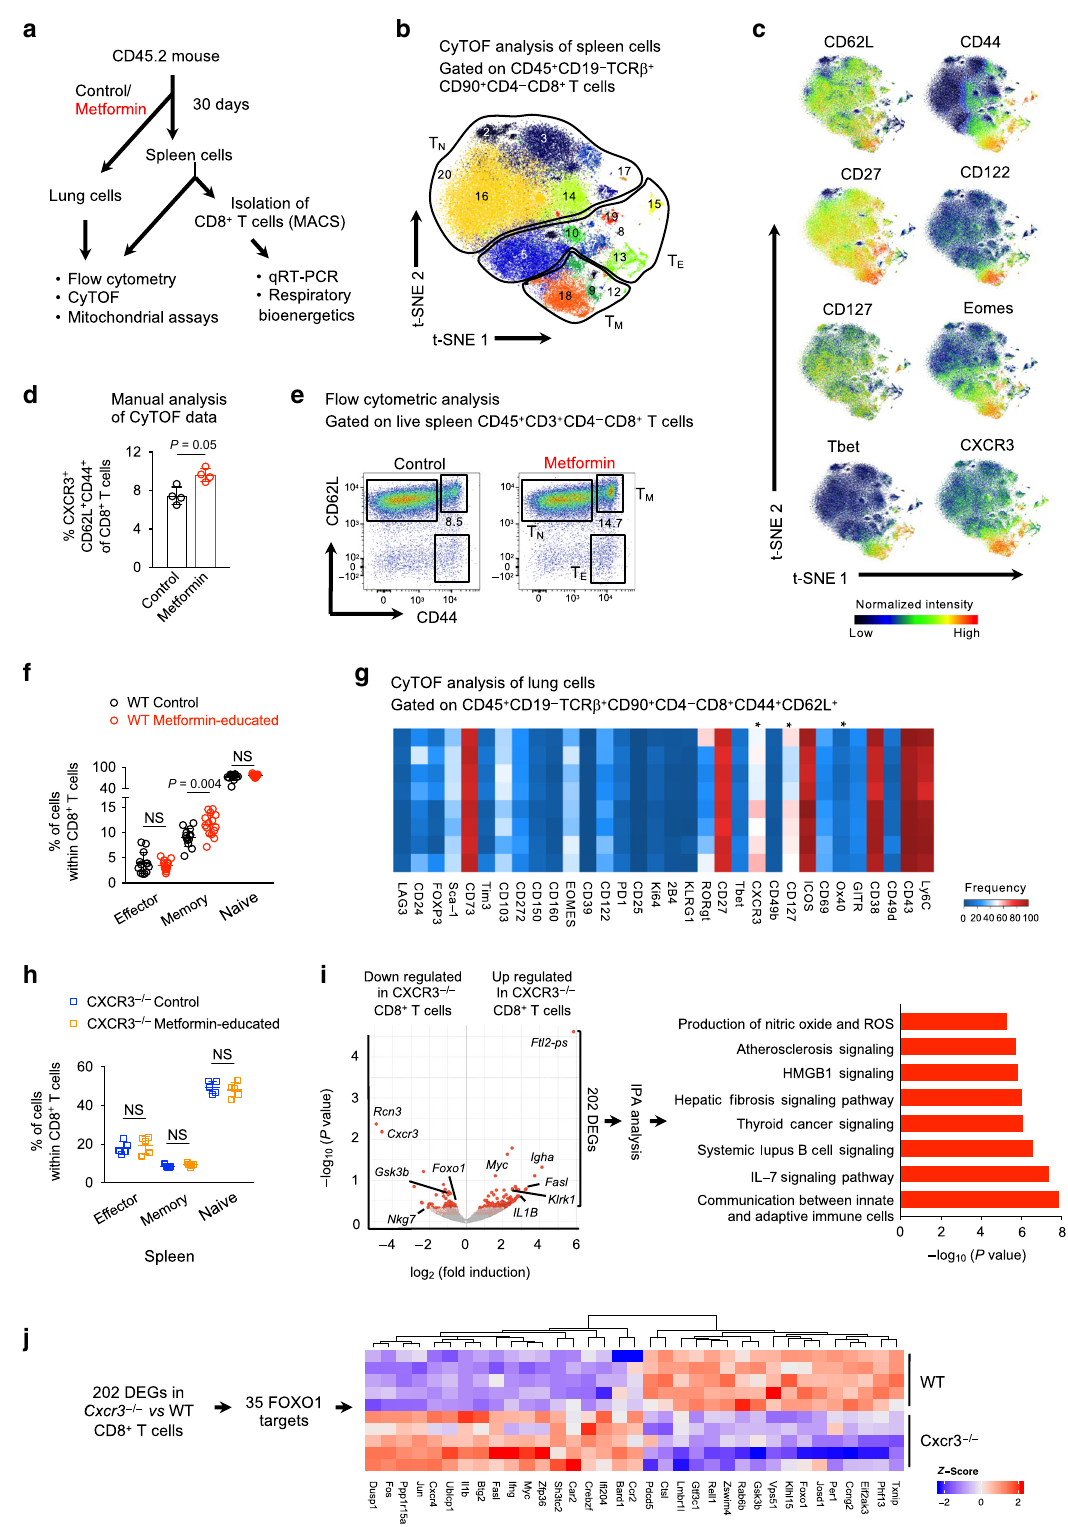
(Supplementary Fig. 4e) from metformin-treated naive mice. To test if CXCR3 was involved in the metformin-mediated expansion of CD8 + T M cells in the spleen and lung, we compared untreated and metformin-treated Cxcr3 − / − mice. The Cxcr3 − / − mice had increased CD8 + T E and reduced CD8 + T M cells compared with WT mice in spleen (Fig. 2h) and lung